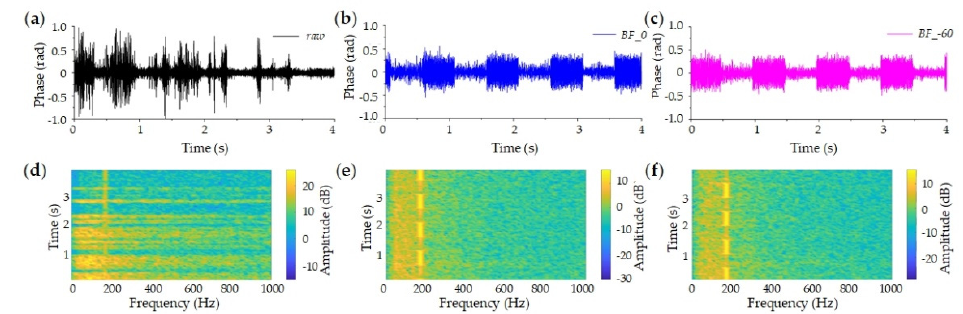
Figure 25. Multi-source signal separation. ( a ) Raw data and processed signals for ( b ) target 1 and ( c ) target 2. ( d – f ) are corresponding spectrograms of ( a – c ). Reproduced with permission from our